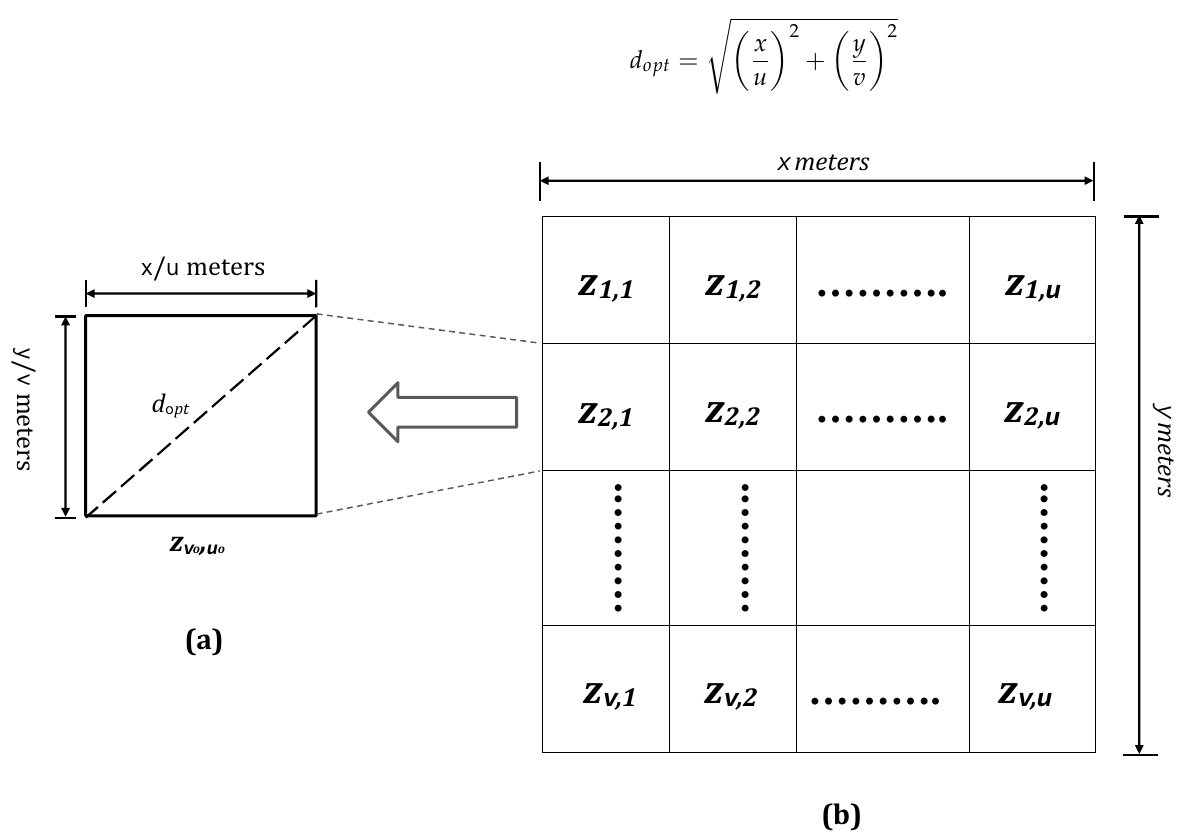
to operate. Figure 4 represents a simple network. Here, Figure 4b is a sample sensing region where sensor nodes are assumed to be deployed. Considered sensing region is segregated into several zones such as { z 1,1 , z 1,2 , · · · z 1, u } { z 2,1 , z 2,1 , · · · z 2, u } { z v ,1 , z v ,2 , · · · z v , u } depend- ing on the requirement of WSN applications. The dimension of sensing region is ( x × y ) m 2 × y ) m 2 . An arbitrary sensing zone Z and dimension of each zone is ( x v 0 , u 0 is shown in u v Figure 4a. If length of the diagonal of each zone is considered as optimal inter cluster head distance, then the selected CH node covers sensing area of four neighbouring zones. Once a node residing at particular zone is selected as CH, then no node should be selected as CH in its neighbour zones. In this manner, CHs are separated by an optimal distance and are able to be separated from one another by a distance of d opt meters. Optimal inter cluster head distance ( d opt ) can be calculated as per Equation (4).